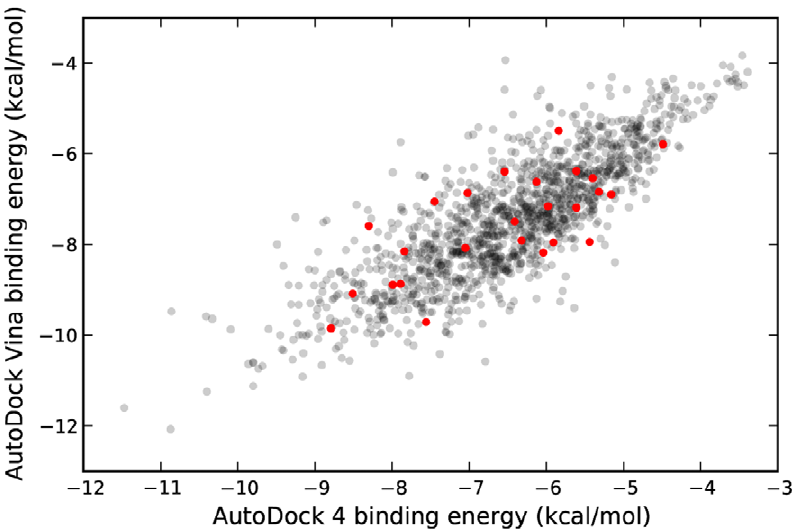
Figure 3. Predicted binding energies for NCI Diversity Set II compounds with HIV protease as determined by AD4 and Vina. A moderately strong correlation was observed ( r =0.63, p % 0.0001). A small amount of random noise ( , 0.1 kcal/mol) was added to Vina binding energies for visual effect. Active compounds are highlighted in red.